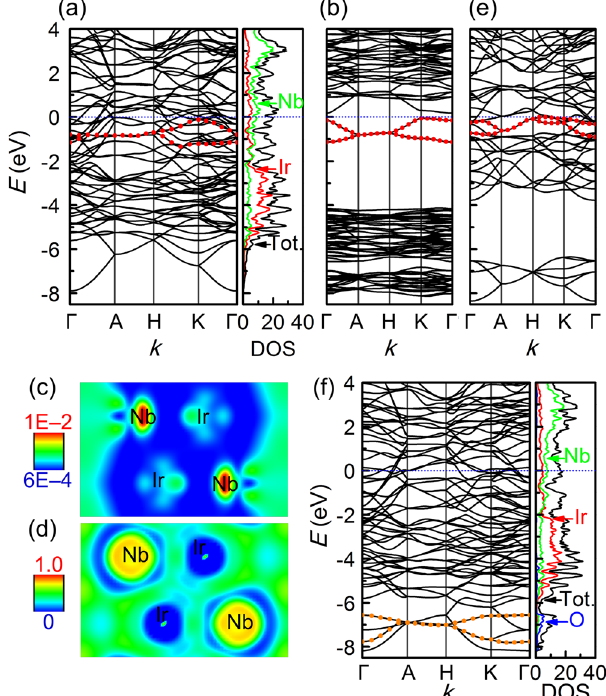
Fig. 2 Electronic structures of different materials. Calculated band structures and density of states (DOS) for a [Nb 5 Ir 3 ] 2+ :2 e − with corresponding electron density for the channel bands (ChBs) and electron localization function (ELF) map on the (1 − 100) plane parallel to the c -axis in c and d , respectively, and f Nb 5 Ir 3 O. b , e Band structures of one-dimensional (1D) electrides b [La 8 Sr 2 (SiO 4 ) 6 ] 4+ :4 e – and e Y 5 Si 3 . The characteristic ChBs are circled in red for all